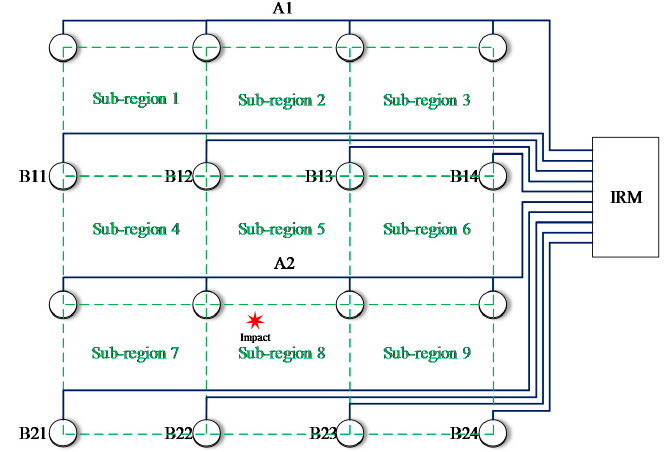
Figure 15. Schematic diagram of the sensor network for illustrating the impact region localization method based on the CHSN.